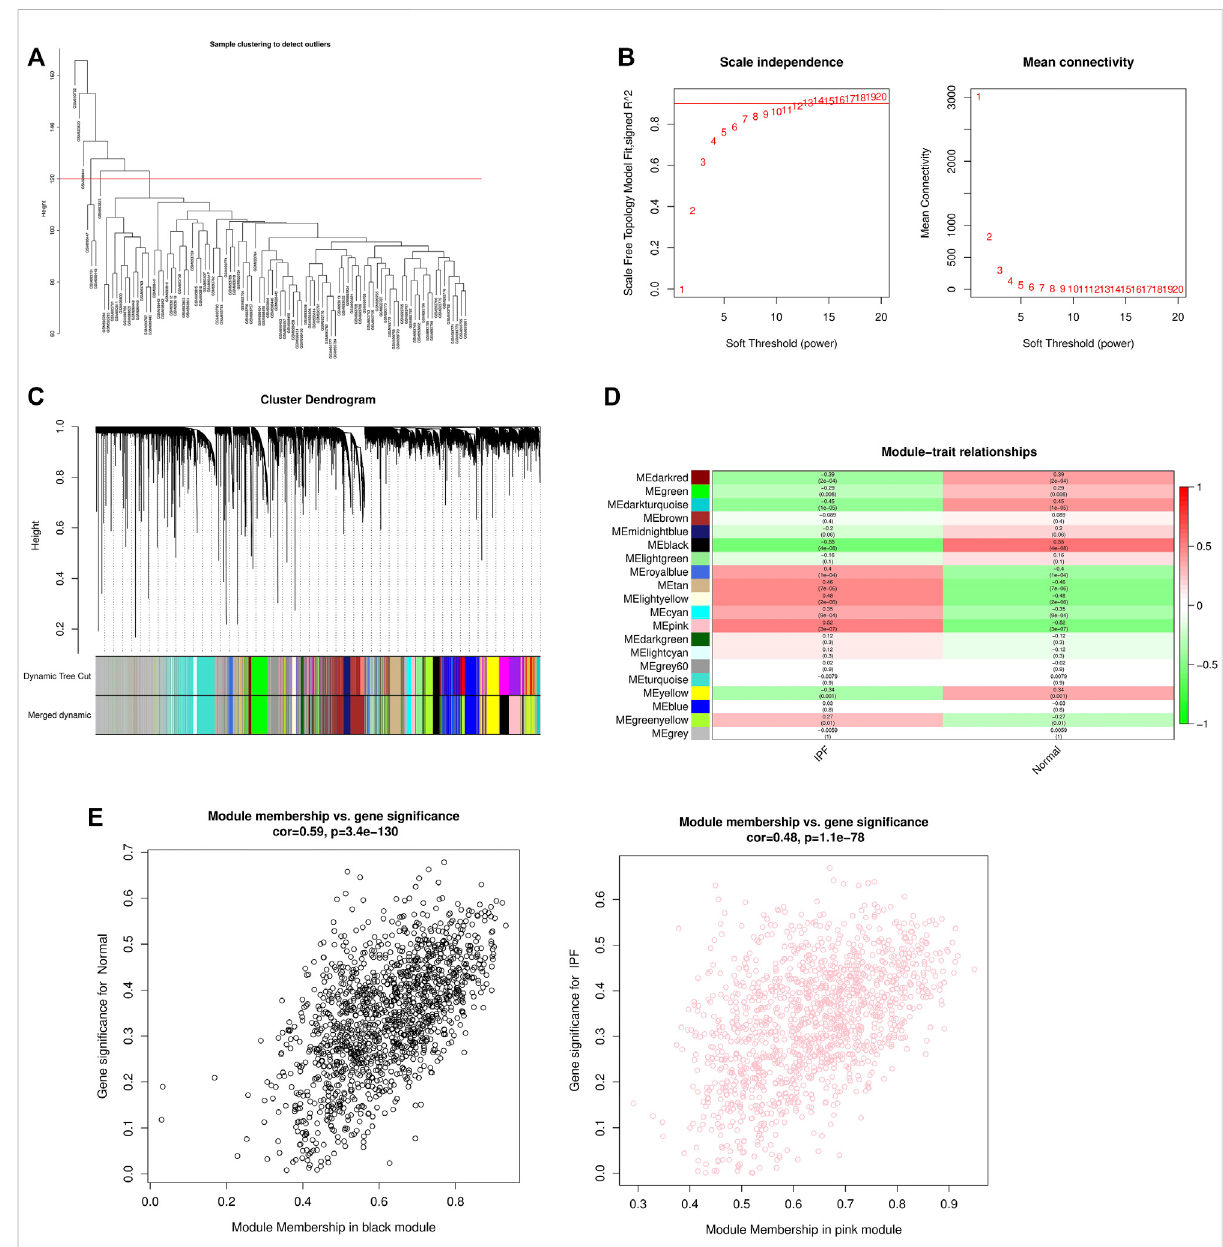
FIGURE 2 WGCNA module construction and selection of modules with high correlation with IPF. (A) Sample clustering diagram (delete 7 outlier samples by setting the height to 120); (B) Determination of the optimal soft threshold (in the process of module selection, the adjacency matrix is converted into a topology matrix, and the optimal soft threshold β = 10 is determined); (C) Cluster tree of co-expressed gene modules (similar genes are grouped into the same module through dynamic splicing and cluster analysis); (D) The correlation between gene modules and clinical information (The redder the color, the higher the positive correlation; the greener the color, the higher the negative correlation. Numbers in the fi gure are Pearson ’ s correlation coef fi cient, and corresponding p -values are in parentheses); (E) The correlation between Black and Pink modules and IPF is represented by scatter